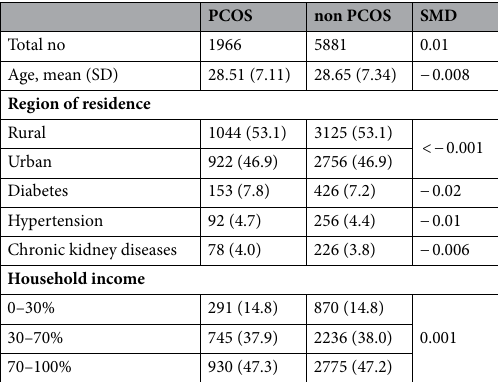
Table 4. Baseline characteristics of propensity score-matched cohorts. PCOS Polycystic ovary syndrome, SMD Standardized mean difference. Data are presented as No. (%).